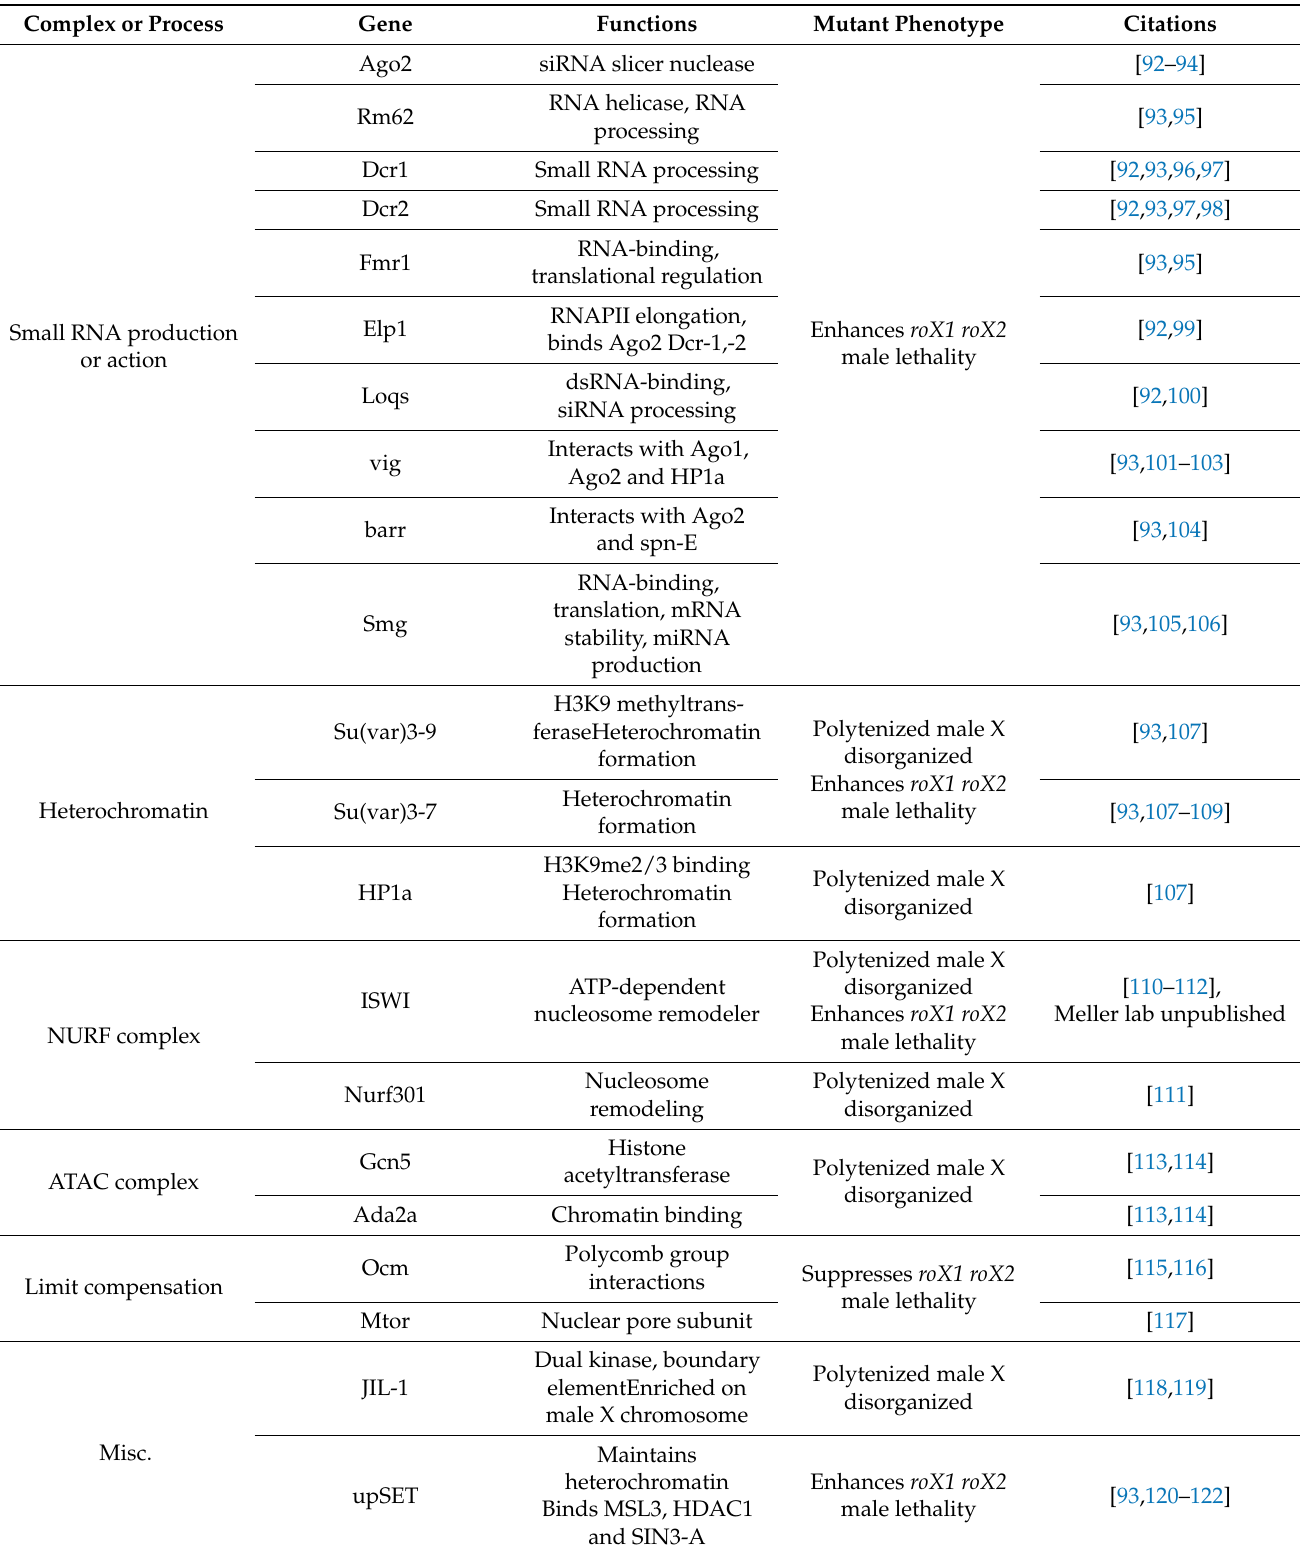
Table 1. Genes that preferentially disrupt the male X chromosome or interact genetically with roX1 roX2 . Genes are grouped by macromolecular complex or molecular process. Many of these are primarily associated with heterochromatin. Mutations that enhance the roX1 roX2 phenotype are often in genes necessary for siRNA production or in the RITS effector